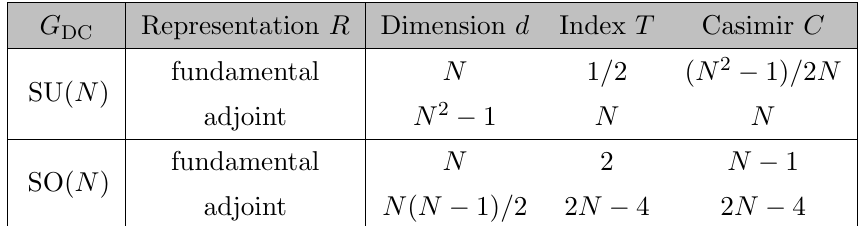
Table 1 . The dimension, the index T and the quadratic Casimir C of fundamental and adjoint SU( N ) and SO( N )